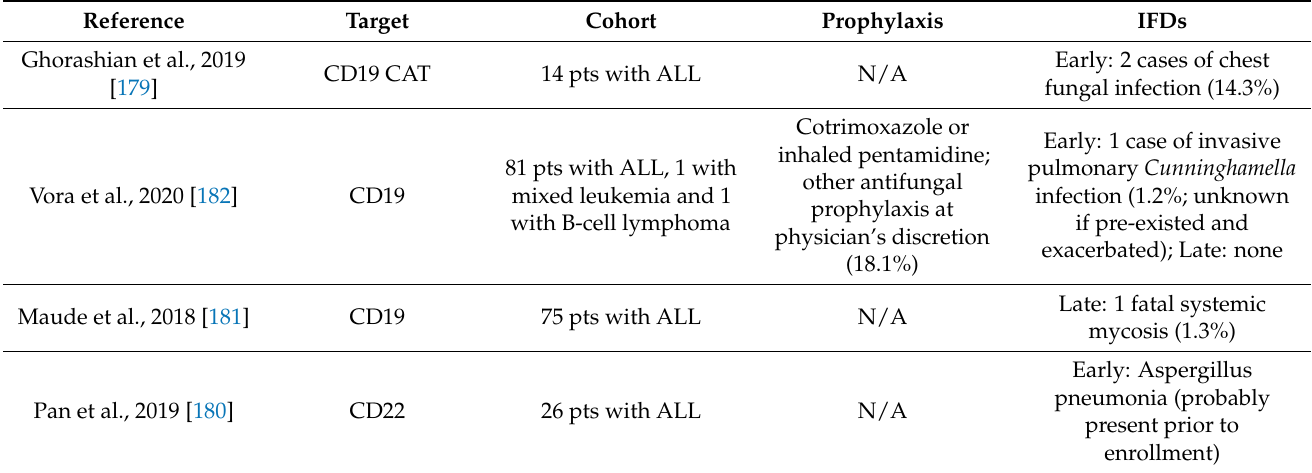
Table 3. Fungal infections associated with CAR T-cells in pediatric